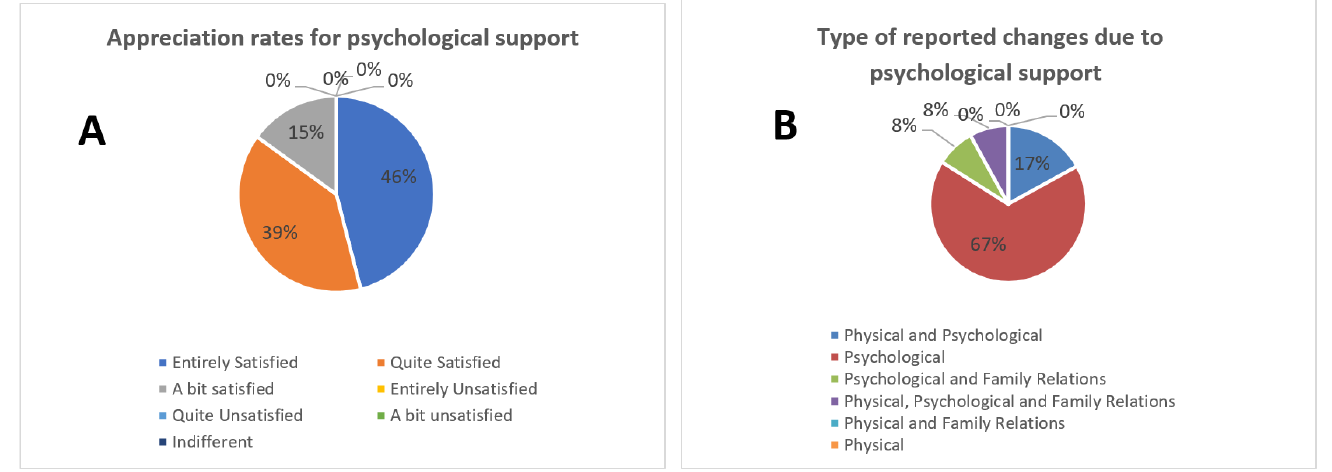
Figure 2. ( a ) Appreciation of psychological support. The majority of our patients were completely (46%) or quite satisfied (39%) with the psychological support and guidance offered both pre- and post-transition to their homes ( b ) Type of changes due to psychological support.